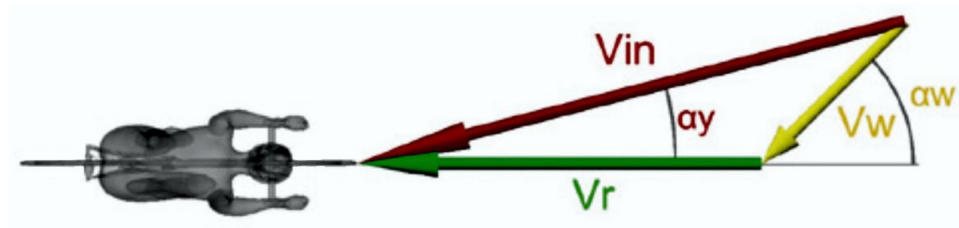
Figure 11. Total wind velocity as perceived by the rider.